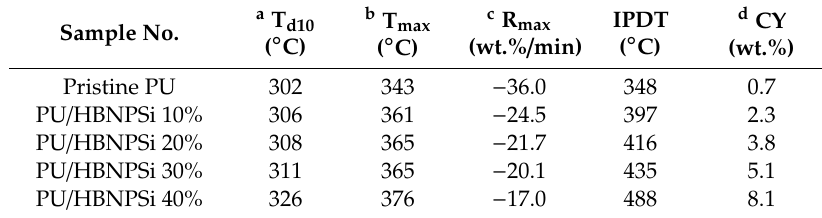
Figure 5. DTG curves of PU/HBNPSi hybrid in N 2 . Table 1. Thermal properties of pristine PU and PU / HBNPSi